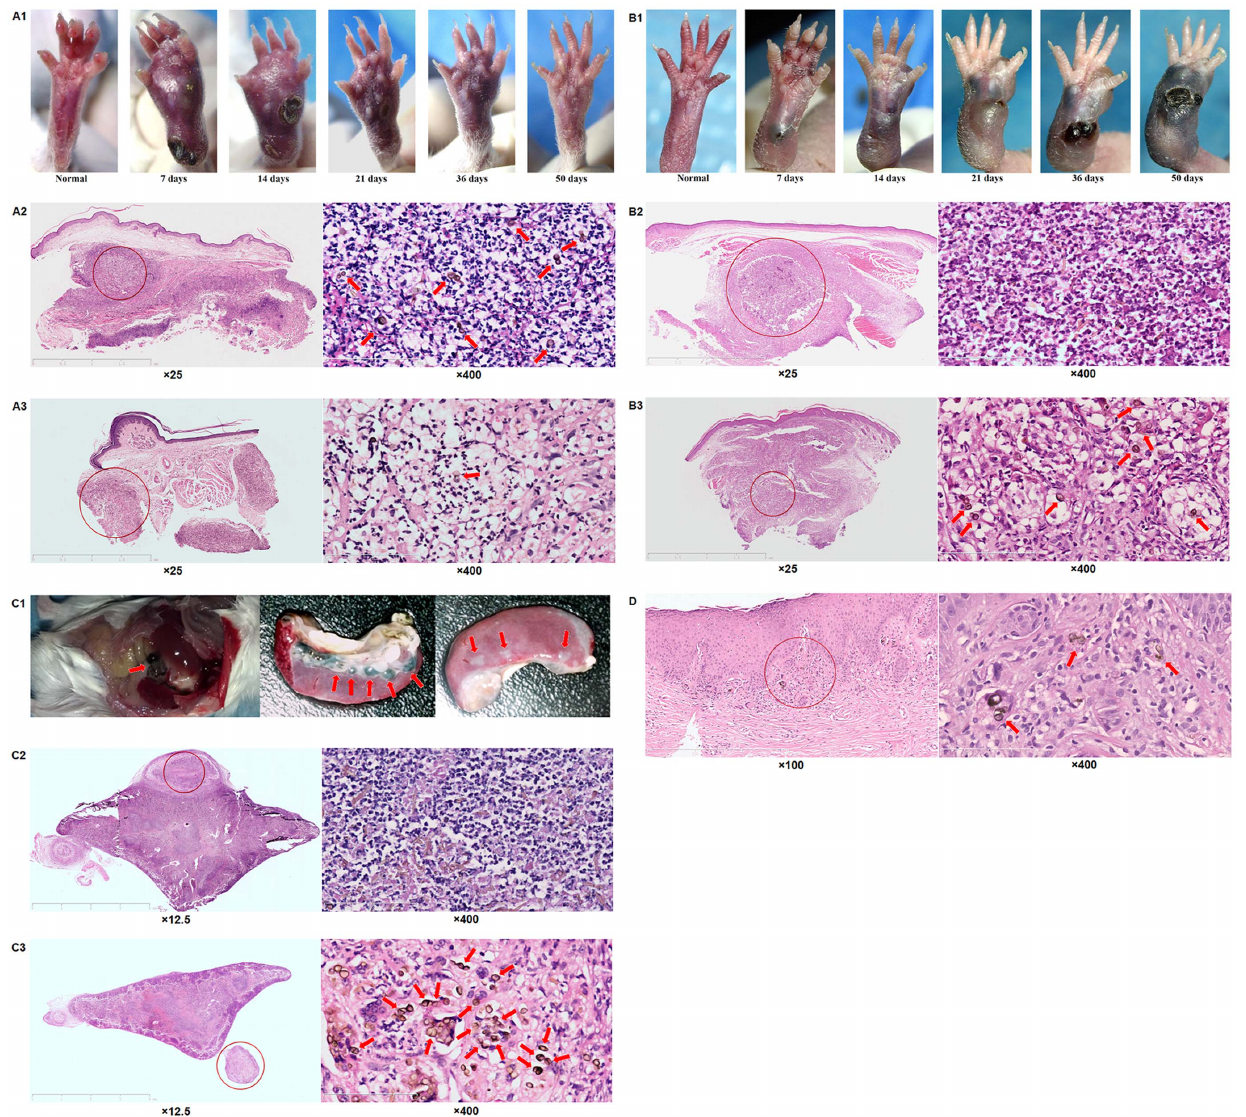
Fig. 1. An inefficient recruitment of neutrophils was observed in chronically infected foci due to F. pedrosoi . (A1–A3) Immunocompetent and athymic (nu/nu) (B1–B3) BALB/c mice were respectively inoculated s.c. with saprophytic F. pedrosoi . (A1 and B1) Images of normal and infected footpads were taken at days 7, 14, 21, 36 and 50 post-inoculation. Infected footpads at days 7 (A2 and B2) and 36 (A3 and B3) were respectively stained for H&E to analyze histological characteristics. (C1–C3) Immunocompetent BALB/c mice were inoculated i.p. with saprophytic F. pedrosoi . (C1) Images of infected foci were taken at days 15(left) and 50 (middle and right) post-inoculation. Infected spleens at days 7 (C2) and 50 (C3) were respectively stained for H&E to analyze histological characteristics. (D1–D2) Tissue sections of the patient with chromoblstomycosis over 10 years were stained for H&E to analyze histological characteristics. (A–D) The transformed sclerotic cells were indicated by red